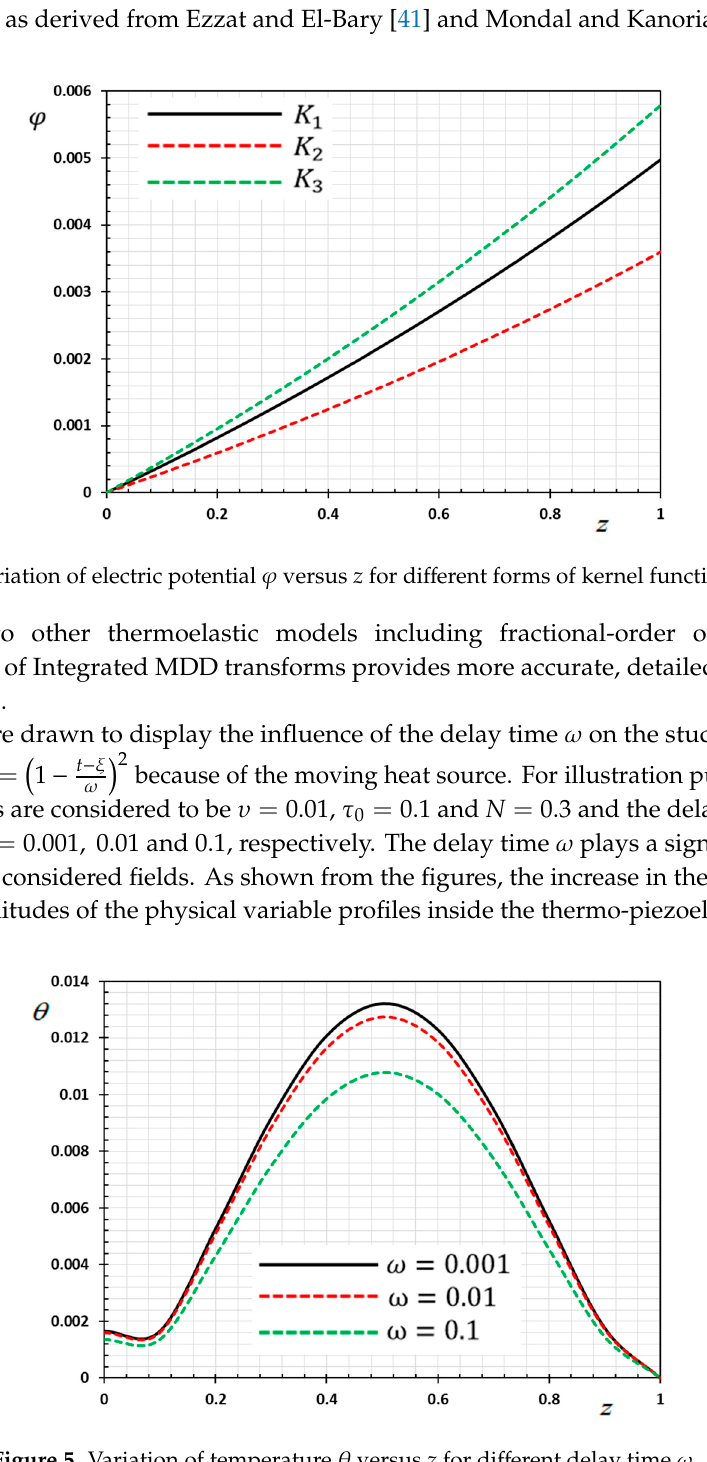
Figure 6. Variation of displacement 𝑤 versus 𝑧 for different delay time 𝜔 .